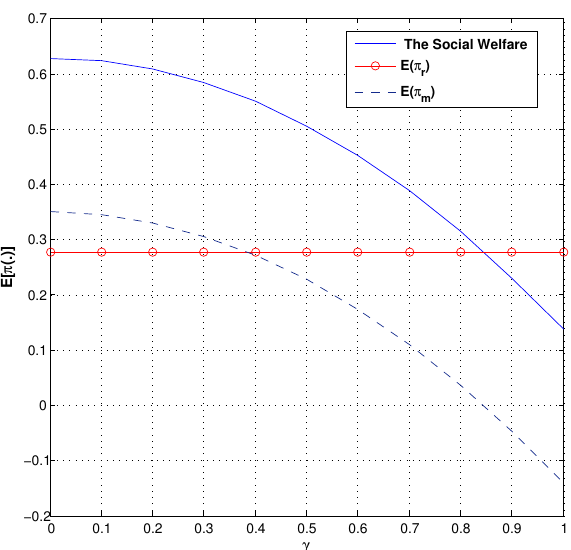
Figure 8. Description of social welfare and λ .